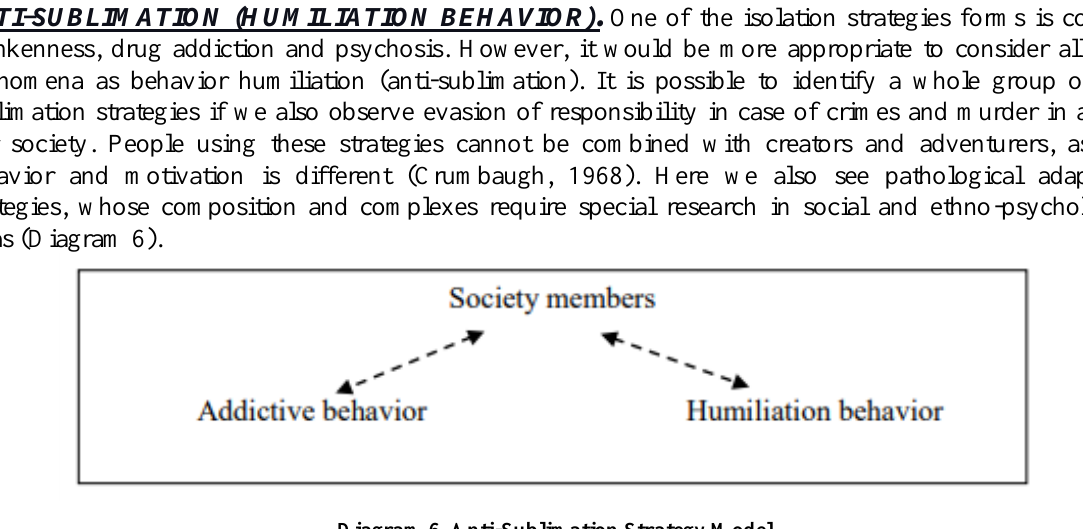
Diagram 6. Anti-Sublimation Strategy